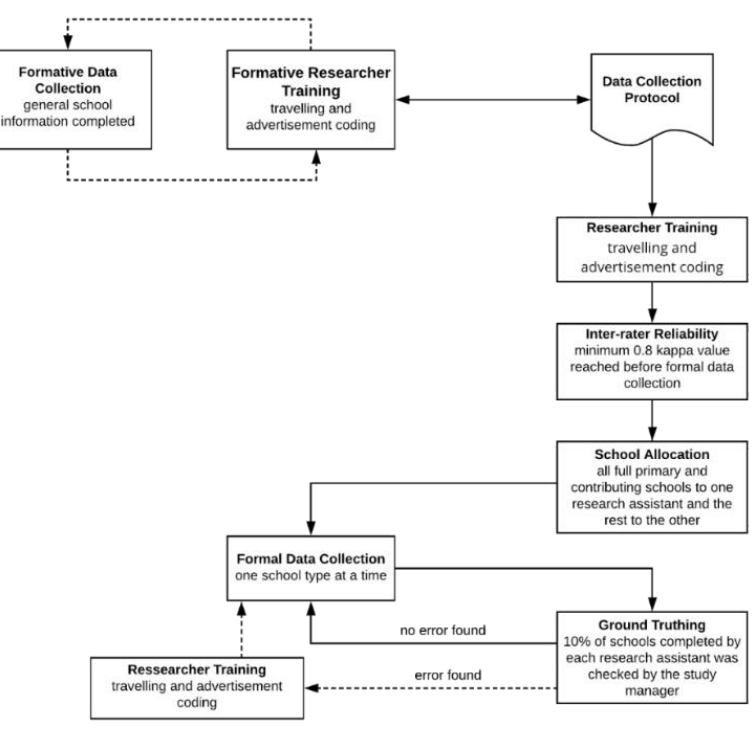
Figure 2. Flow Chart of Data Collection Processes.